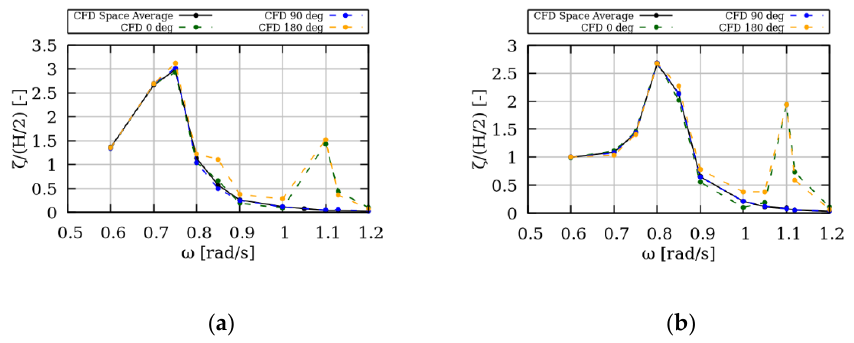
Figure 14. Analysis of the instantaneous free surface elevations inside the moonpool of Configuration 1 ( a ) and Configuration 2 ( b ) The position of the wave gauges is shown in Figure 13a. The non ‐ dimensional amplitude of the free surface elevation ( ζ /(H/2)) is plotted for the various wave frequencies.